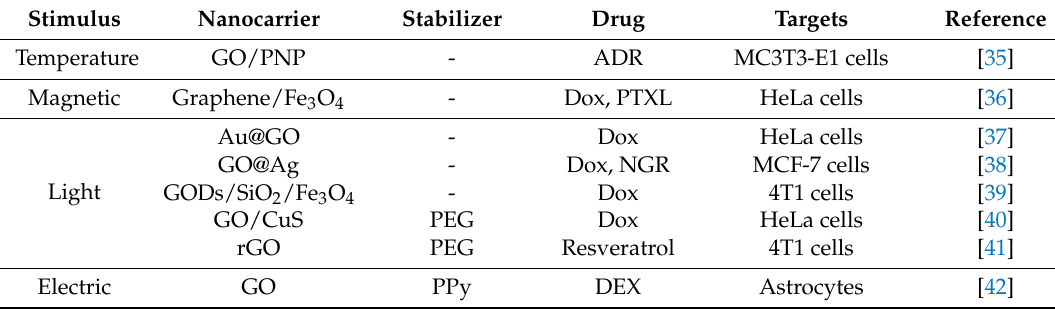
Table 1. Stimuli-responsive drug-delivery systems of graphene-based materials 1